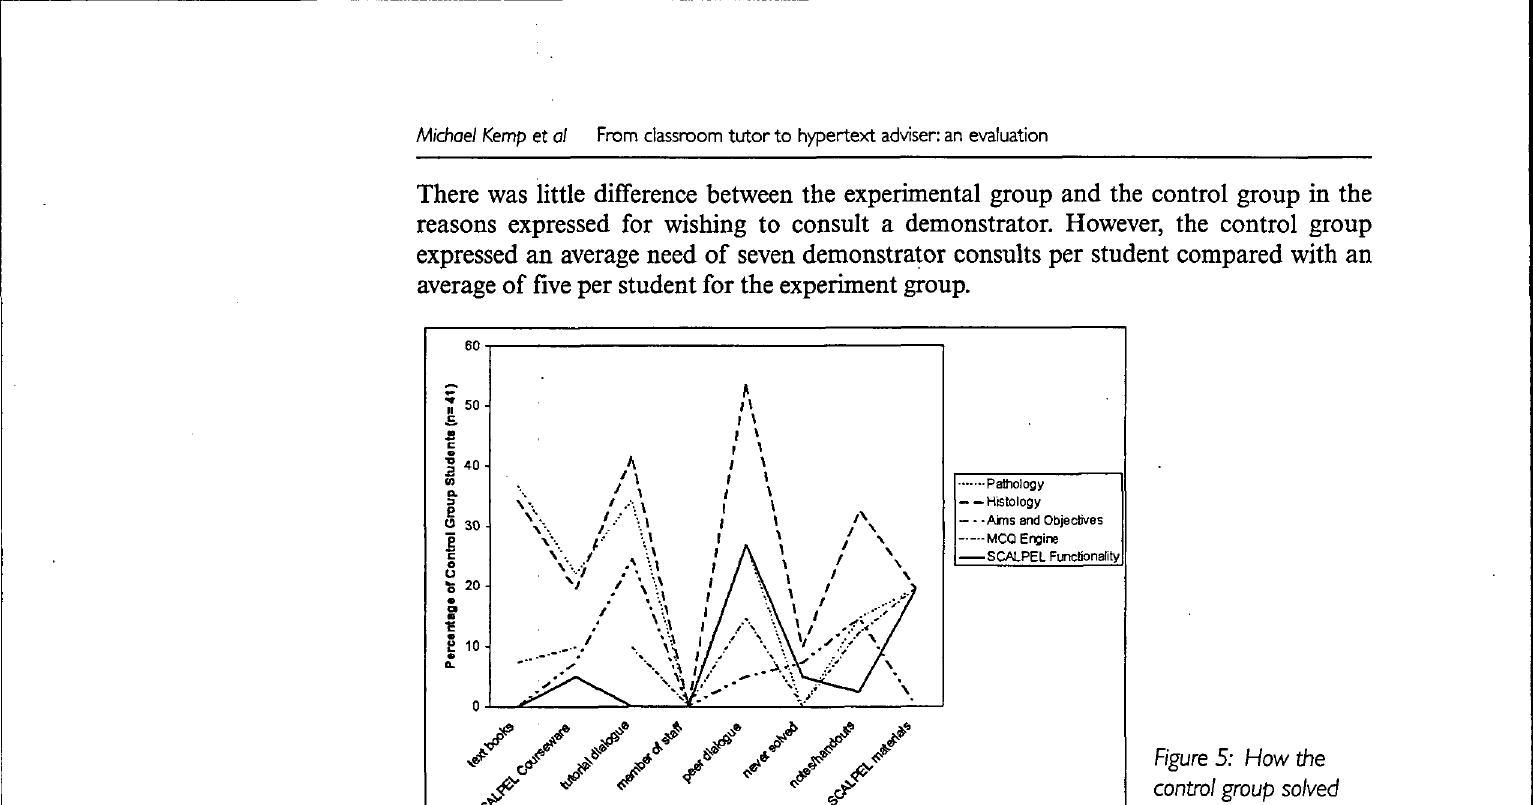
Figure 5: How the